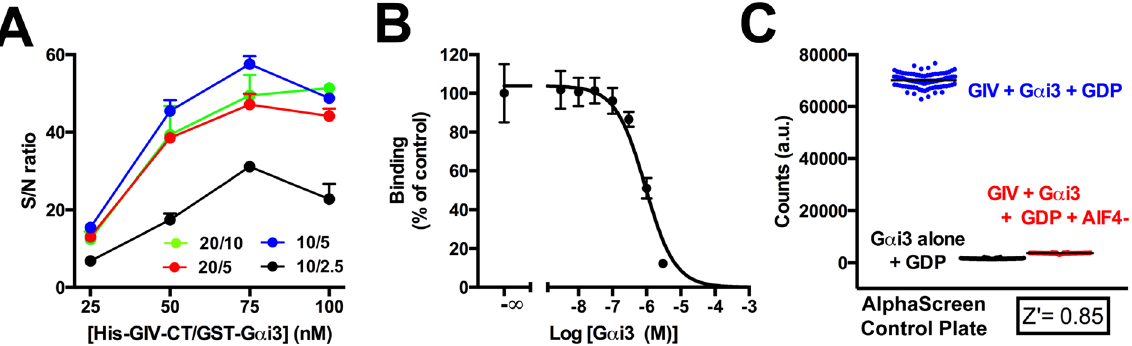
Figure 5. Validation of an AlphaScreen assay to measure G α i3-GIV binding and assessment of its suitability for high-throughput screening. ( A ) Optimization of reagent concentrations to obtain maximal signal-to-noise ratio (S/N) in AlphaScreen ® assays. The indicated concentrations of His-GIV-CT (1660–1870) and GST-G α i3 (equimolar; represented in the X-axis) were incubated in the presence of the indicated concentrations ( µ g/ml) of AlphaScreen donor and acceptor beads. S/N ratios (represented in the Y-axis) were determined dividing the AlphaScreen ® signal in the presence of both GIV and G α i3 by the signal detected in the presence of G α i3 alone. Results are expressed as mean ± S.E. of 3 independent experiments. ( B ) Inhibition of the G α i3/GIV binding signal in AlphaScreen assays by untagged G α i3. 75 nM proteins (His-GIV-CT and GST-G α i3 protein), 10 μ g/mL of donor beads and 5 μ g/mL of acceptor beads were incubated in the presence of the indicated concentrations of unlabeled G α i3. AlphaScreen signals were normalized to the value in the absence of untagged G α i3 and fitted to a one-site sigmoidal inhibition curve as described in Methods . Results are expressed as mean ± S.E. of 3 independent experiments. ( C ) Scatter plot of positive and negative control data points and Z’ determination for the G α i3-GIV binding AlphaScreen assay. Measurements were carried out in a 384-well format with 75 nM proteins (His-GIV-CT and GST-G α i3 protein), 10 μ g/mL of donor beads and 5 μ g/mL of acceptor beads in buffer containing GDP alone (blue, negative controls) or GDP + AlF 4 − (red, positive controls). An additional condition in the presence of GDP but omitting His-GIV-CT was also included (black dots). Z’ was calculated from the positive and negative control data points as described in Methods